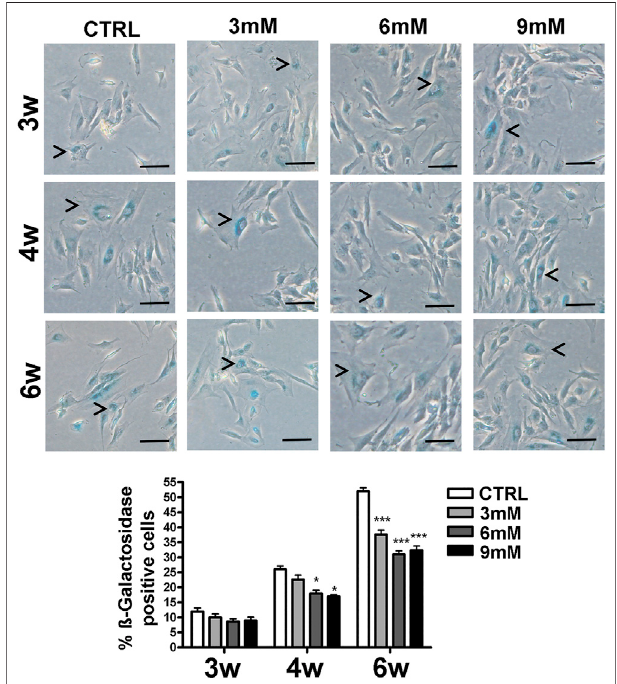
FIGURE 1 | Senescence levels in MSCs cultures. This histogram shows thepercentageofsenescentcellsafterthree(3w),four(4w)andsix(6w)weeks of in vitro culture, either in the absence (CTRL) or presence of metformin. Data are shown with a standard deviation (SD) n (cid:1) 3 * p < 0.05, *** p < 0.001. For each time point, the symbol (*) indicates the statistical difference between the control culture and those treated with metformin. The pictures show representative images of senescent cells that tested positive for the beta- galactosidaseactivity(blue).Thearrowheadsindicatesometypicalsenescent cells, which show fl attened morphology and blue staining in the perinuclear area. The bar corresponds to 100